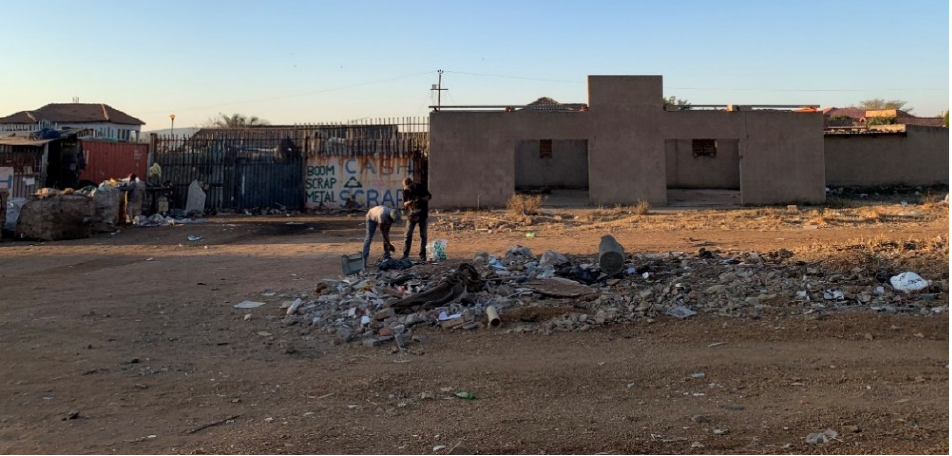
Figure 2. Waste dumped on the side of the street in an informal settlement.